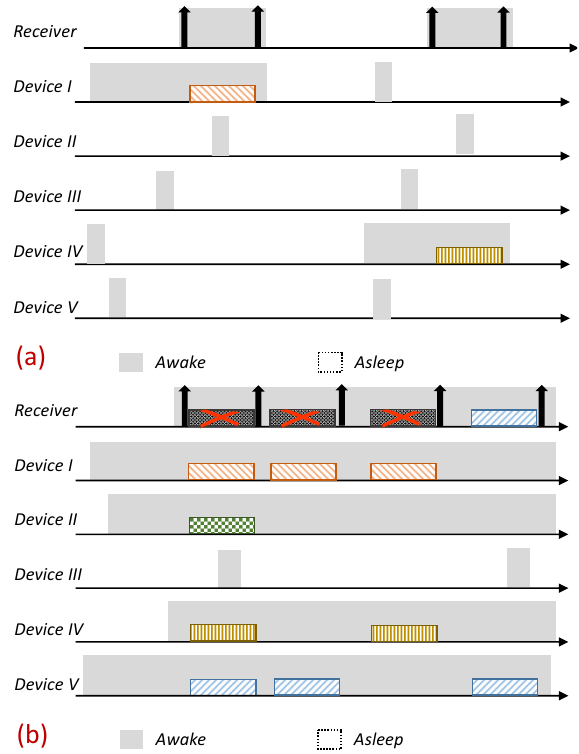
Figure 1. Overview of the Receiver-Initiated Medium Access Control (MAC) (RI-MAC) protocol. A backlogged device waits silently for its intended receiver beacon to start its data transmission. A non-backlogged device wakes up periodically, broadcasts its wakening notification, and, if no device transmits to it, goes back to sleep. ( a ) Under low load. ( b ) Under high load, when multiple devices attempt transmission simultaneously, a collision resolution procedure is